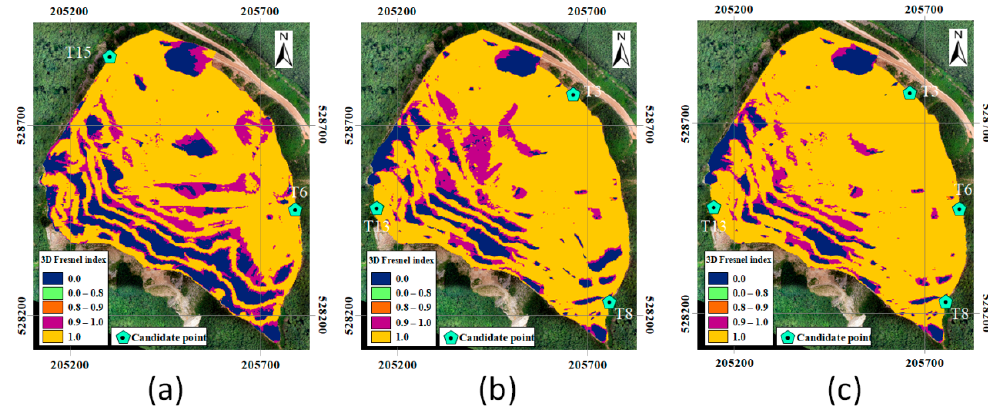
Figure 11. Three-dimensional Fresnel index overlay maps for the favorable transmitter candidate combinations when two, three, and four transmitter candidates were combined: ( a ) combination of T6 and T15, ( b ) combination of T3, T8, and T13, and ( c ) combination of T3, T6, T8, and T13.